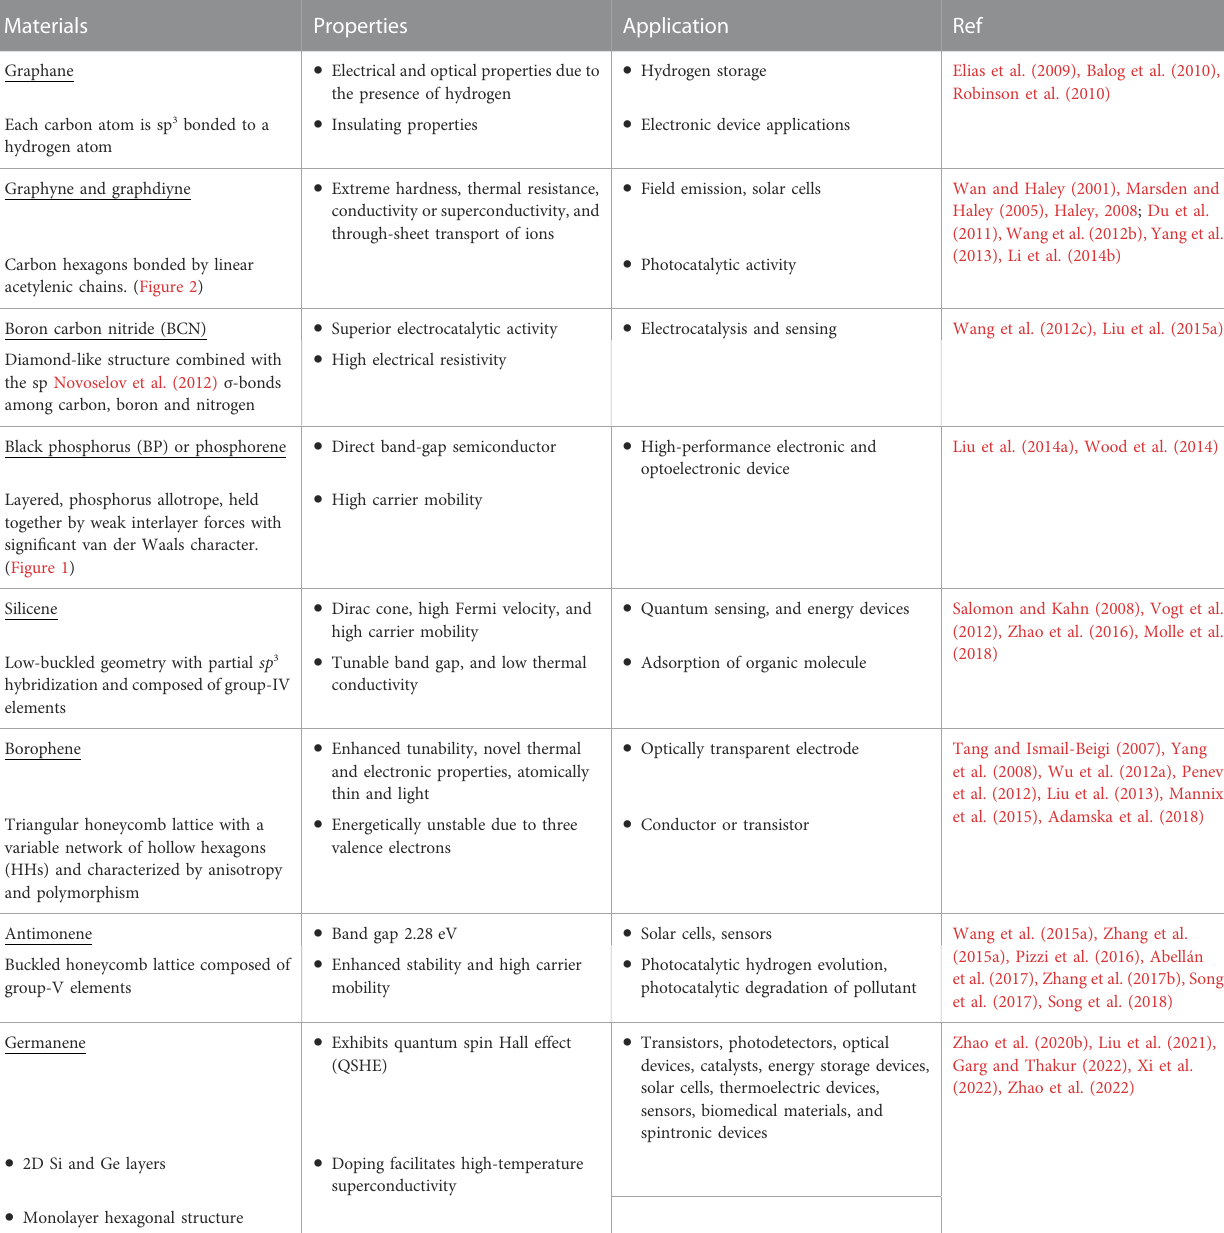
TABLE 2 Properties and applications of graphene derivatives and elemental graphene analogues.